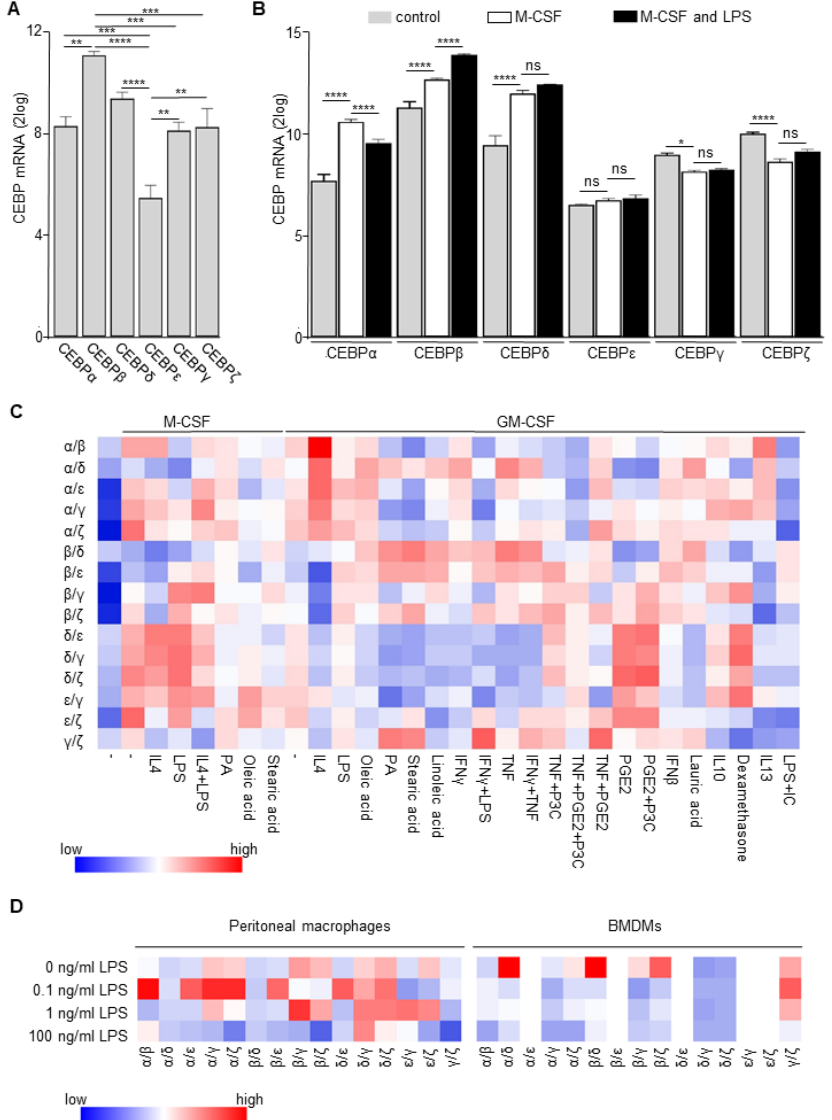
Figure 2. CEBP family member expression in monocytes and macrophages. ( A ) C/EBP α , C/EBP β , C/EBP δ , C/EBP, C/EBP γ and C/EBP ζ mRNA expression in freshly isolated human monocytes derived from GSE5099 and GSE46903. Mean ± SEM ( n = 3); **: p < 0.01; ***: p < 0.001; ****: p < 0.0001. ( B )